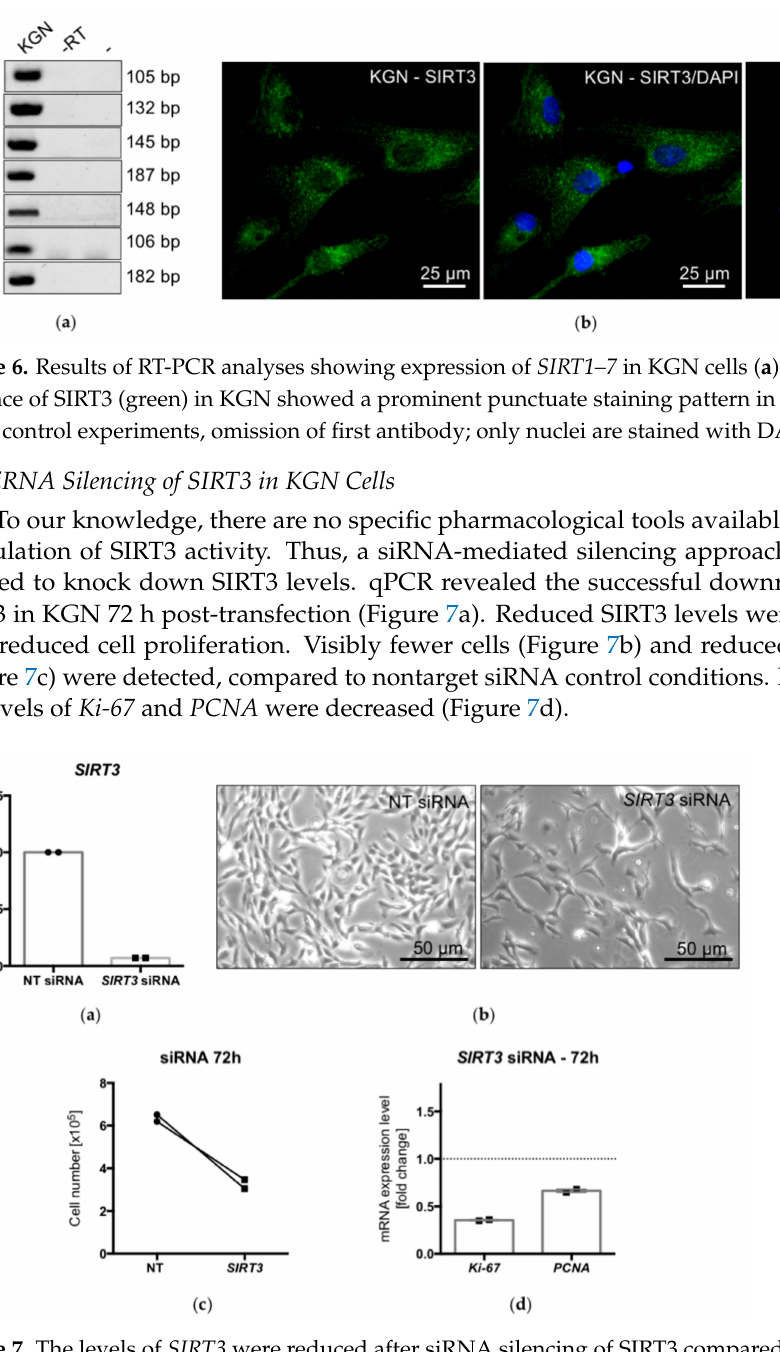
Figure 7. The levels of SIRT3 were reduced after siRNA silencing of SIRT3 compared to NT siRNA controls ( n = 2) ( a ). Live cell images of cultured KGN, under control conditions (nontarget = NT siRNA) and after siRNA silencing of SIRT3 ( b ). Lower cell counts after transfection ( c ) and reduced levels of the proliferation markers Ki-67 and PCNA ( d ) ( n =